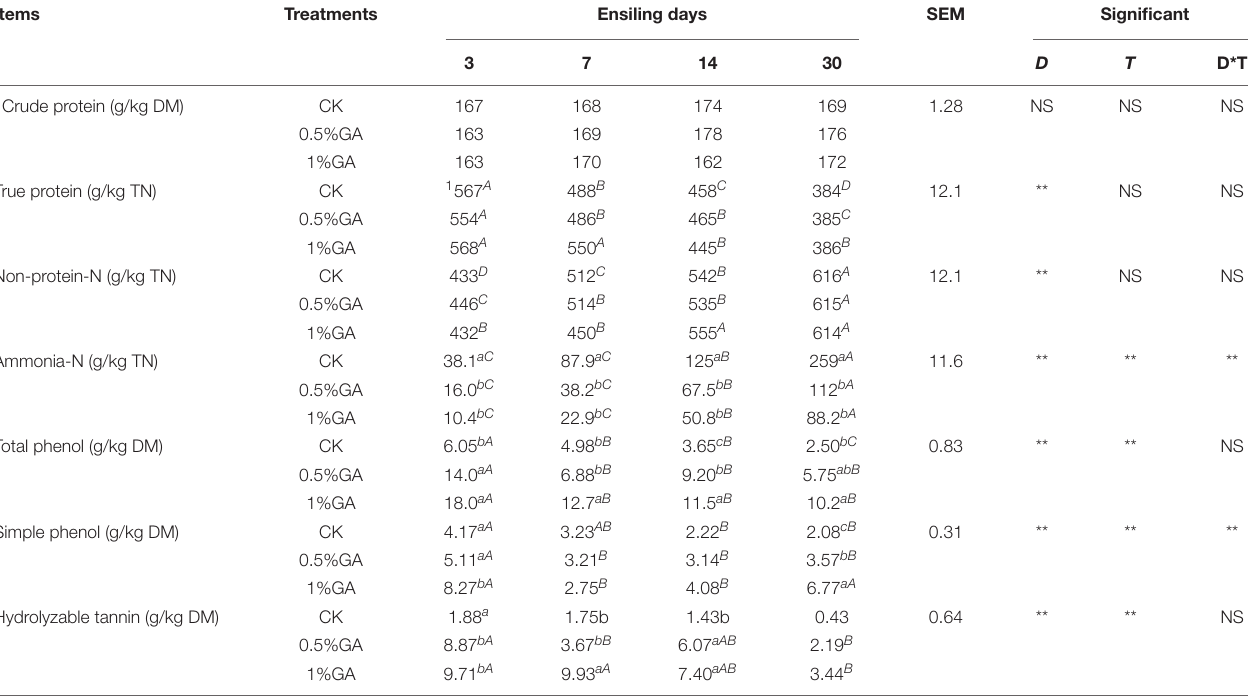
TABLE 3 | Protein fractions and tannin content of ensiled whole plant soybean. Items